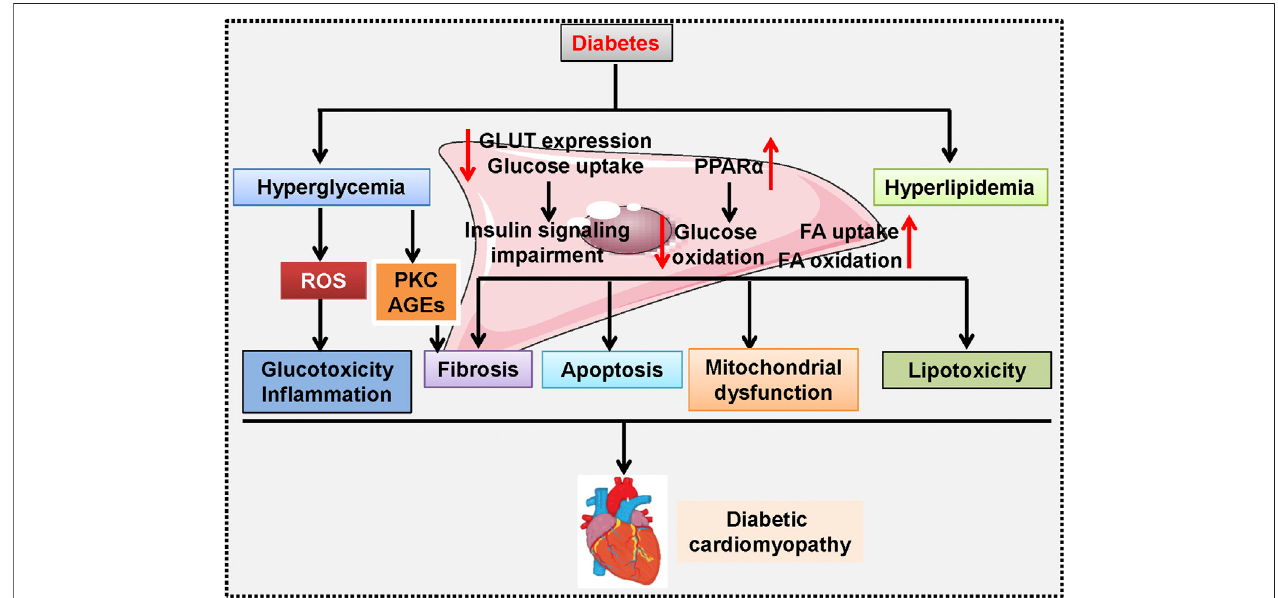
FIGURE 1 | A proposed schematic diagram showing the signaling pathways involved in diabetic cardiomyopathy-related cardiac dysfunction. Hyperglycemia induces ROS overproduction and causes glucotoxicity and in fl ammation in the heart, and activation of PKC promotes AGEs formation, a critical event involved in diabetes-induced cardiac fi brosis. In cardiomyocytes, high glucose inhibits GLUT expression and glucose uptake, but upregulates PPAR α to reduce glucose oxidation, thus resulting in insulin signaling impairment. Moreover, hyperlipidemia stimulates FA uptake and oxidation, and renders cardiomyocytes more sensitive to lipotoxicity. All these above changes synergistically contribute to fi brosis, apoptosis, mitochondrial dysfunction, and hypertrophy during the development and progression of diabetic cardiomyopathy. AGE: advanced glycation end products; FA: fatty acids; GLUT: Glucose transporters; PKC: Protein kinase C; PPAR α : Peroxisome proliferator activated receptor α ; ROS: reactive oxygen species.